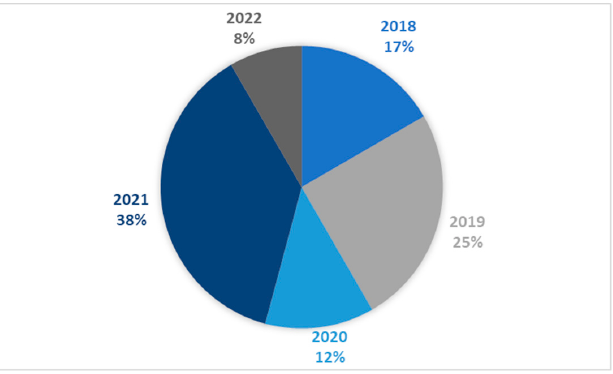
Figure 2. Distribution of included articles according to year of publication. Source: author’s elabo ‐ ration.